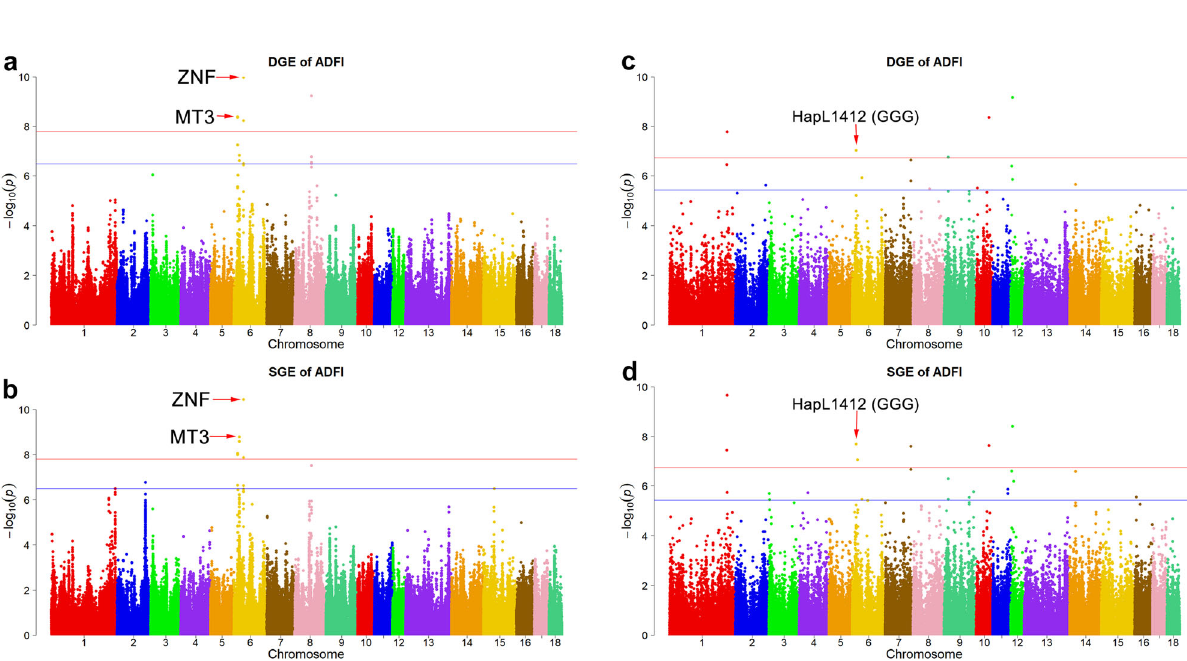
Fig. 3 GWAS results for direct genetic effects (DGE) and social genetic effects (SGE) in average daily feed intake (ADFI). a for DGE using imputed- GWAS; b for SGE using imputed-GWAS; c for DGE using haplotype-based GWAS; d for SGE using haplotype-based GWAS. For imputed-GWAS, the horizontal red and blue lines indicate the genome-wide (1.63 × 10 − 8 ) and suggestive (3.25× 10 − 7 ) level, respectively. For haplotype-based GWAS, the horizontal red and blue lines indicate the genome-wide (1.82 × 10 − 7 ) and suggestive (3.64 × 10 − 6 ) level,